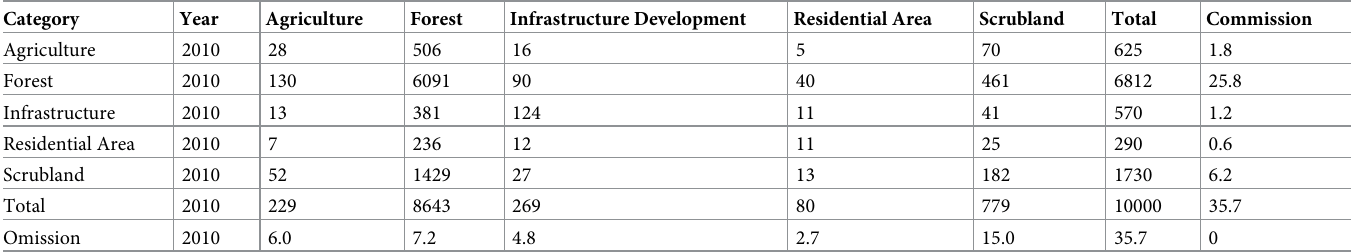
Table 1. Accuracies based on an accuracy assessment of the two LULCC maps for 2010. Rows are map categories, and columns are reference categories.